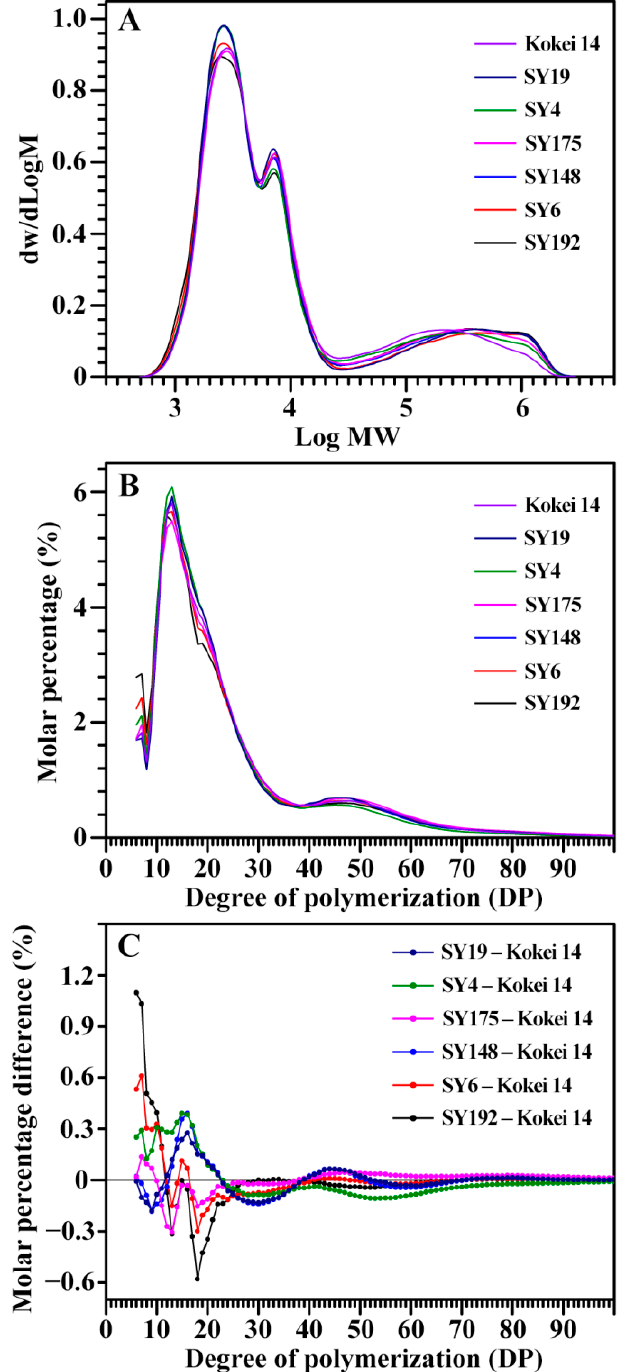
Figure 2. Gel permeation chromatography profiles of isoamylase-debranched starches ( A ) and fluorophore-assisted capillary electrophoresis profiles of isoamylase-debranched amylopectins ( B , C ) from different sweet potato varieties.